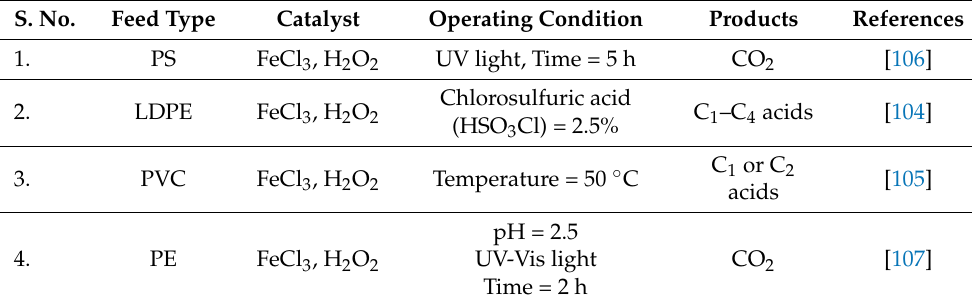
Table 9. Fenton oxidation process for plastic waste conversion. S.